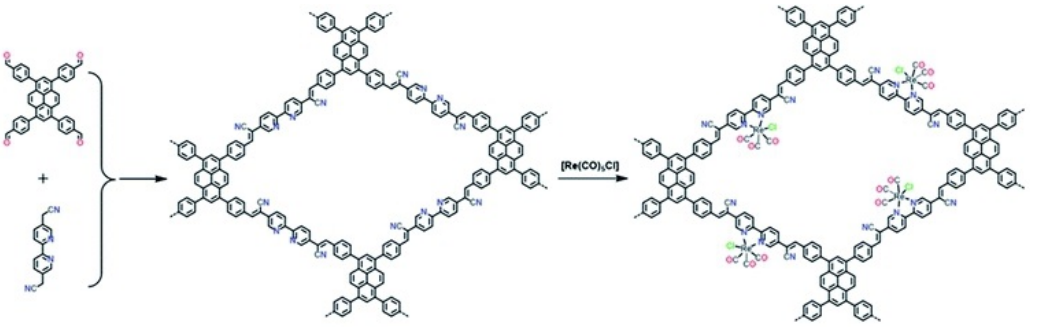
Figure 6. Synthesis of Bpy-sp 2 c-COF and Re-Bpy-sp 2 c-COF. Conditions for Bpy-sp 2 -c-COF: KOH (4 M) 1,2-dichlorobenzene and 1-butanol (1: 1 mixture), 120 ◦ C, 72 h. Copied with permission form Royal Society of Chemistry 2020